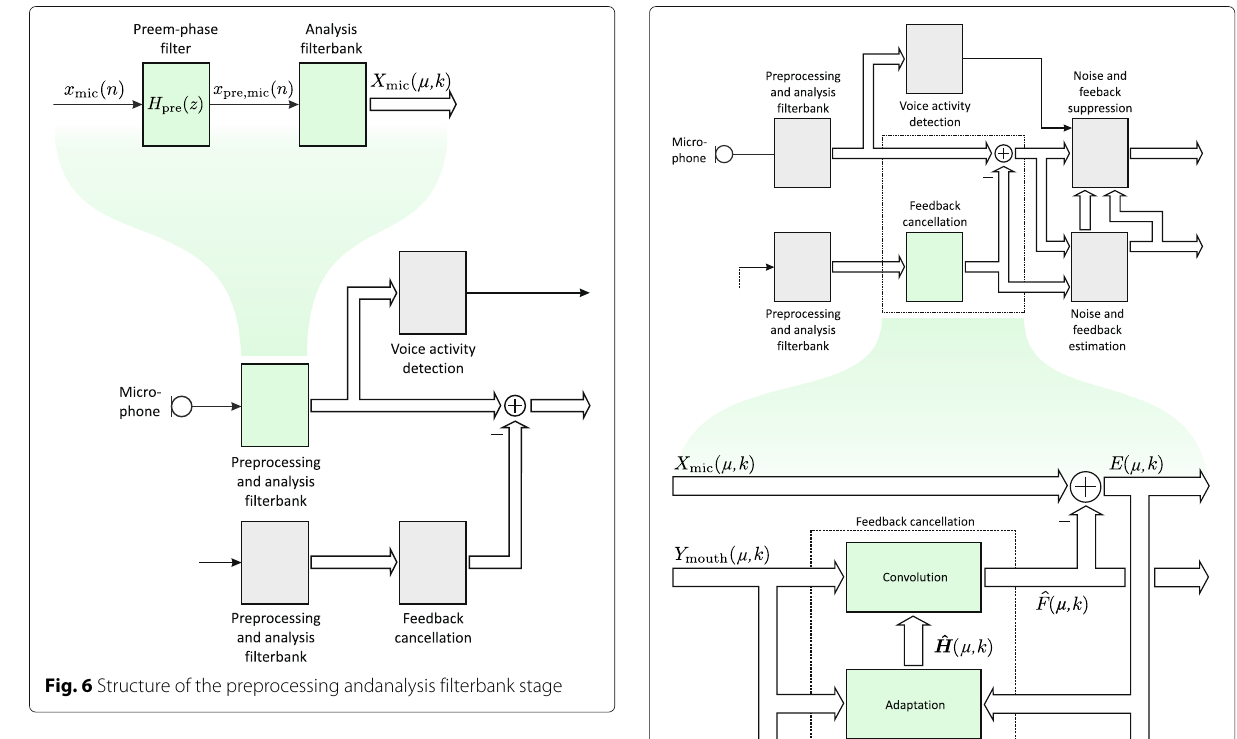
the same signal in an ideal case, but from the perspec- tive of system identification attempts, a non-uniqueness and a robustness problem arises from that correlation.